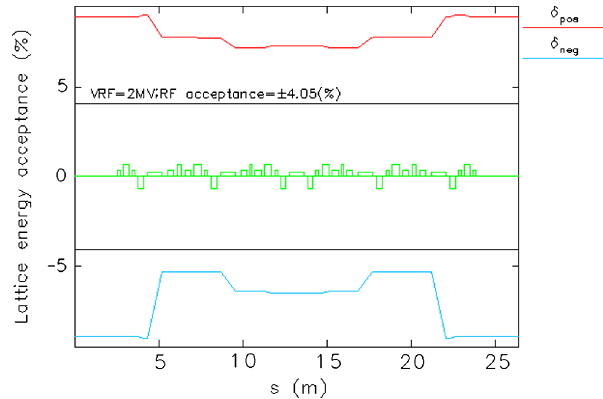
FIG. 18. Lattice momentum acceptance in a super period of the storage ring. The red and blue curves represent positive and negative energy acceptances. (cid:3) 4 . 05 % rf acceptance is specified with straight black lines.